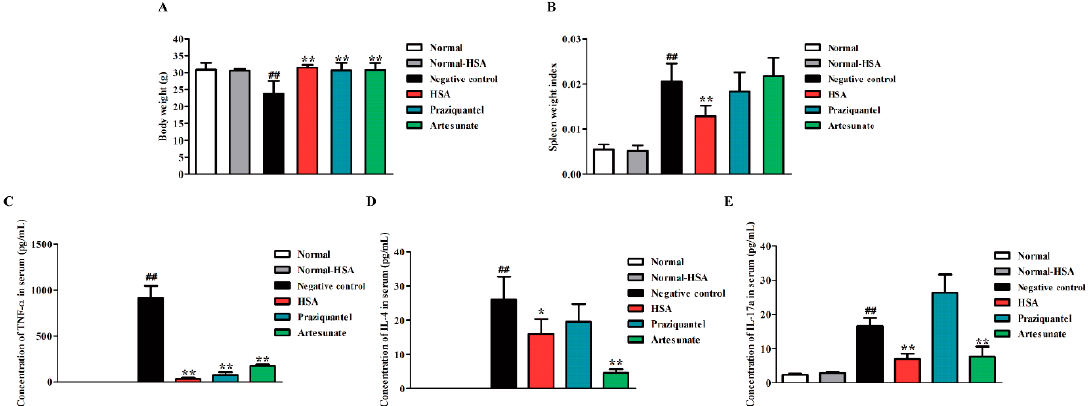
Figure 4. Immune responses in S. japonicum infected mice reduced by HSA. Antischistosomal effects on immune responses of 7-week-infected drug-untreated and drug-treated mice. ( A ) Statistical analysis of body weights; ( B ) Spleen weight index (spleen weight/body weight); ( C ) Expression of TNF- α in S. japonicum infected mice serum with different treatment; ( D ) Expression of IL-4 in S. japonicum infected mice serum with different treatment; ( E ) Expression of IL-17a in S. japonicum infected mice serum with different treatment. Each bar represents the mean ± SD. Each bar represents the mean ± SD. ## p < 0.01 vs. Normal mice; * p < 0.05 vs. Negative control; ** p < 0.01 vs. Negative control, t -test.